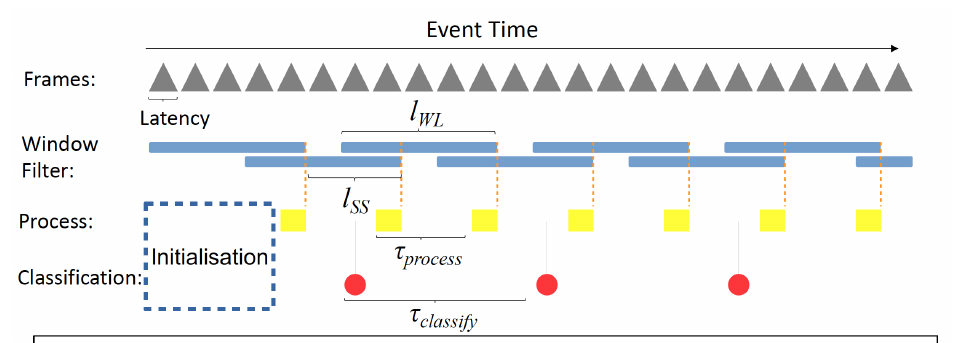
Figure 3. Operation of proposed window